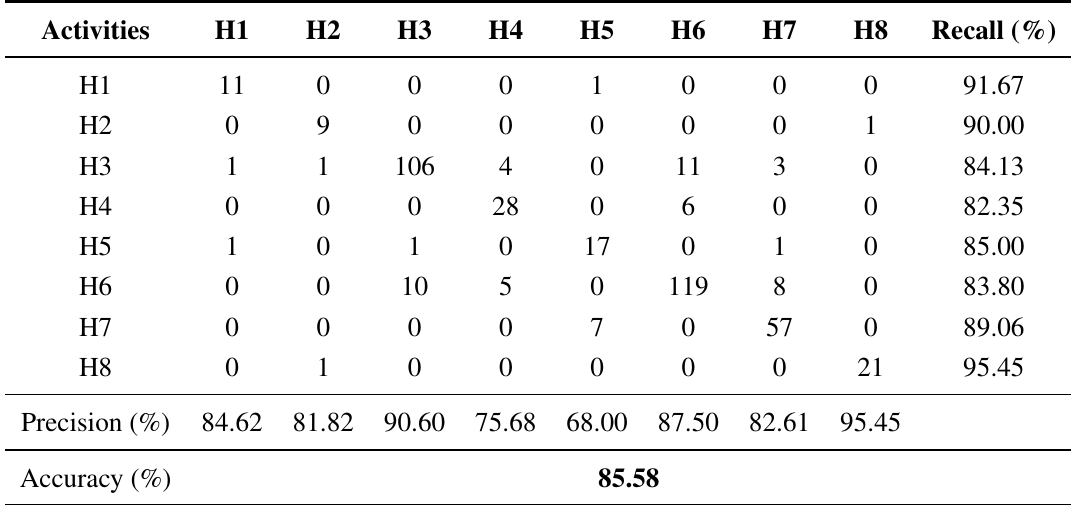
Accuracy (%) Table 7. Confusion matrix of the SVM classifier using LDA for the horizontal traffic. Activities